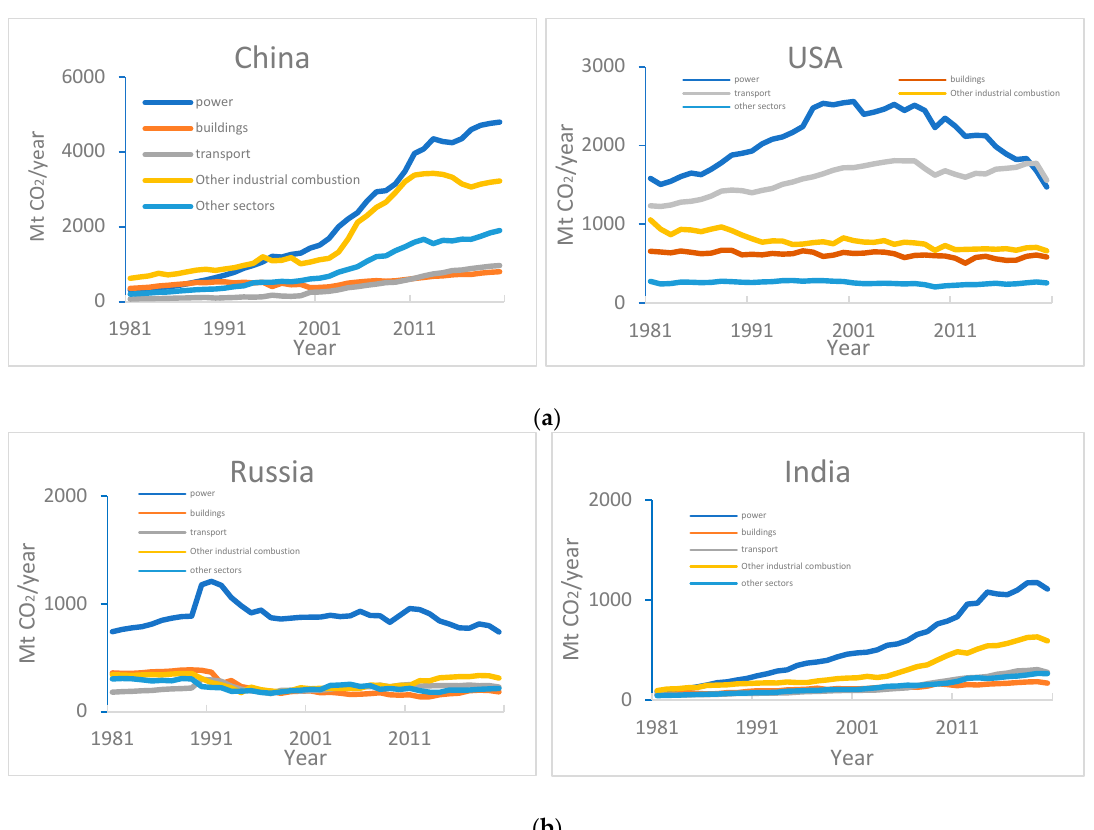
Figure 1. ( a ) The distribution of carbon emissions in China and the USA. ( b ) The distribution of carbon emissions in Russia and India.